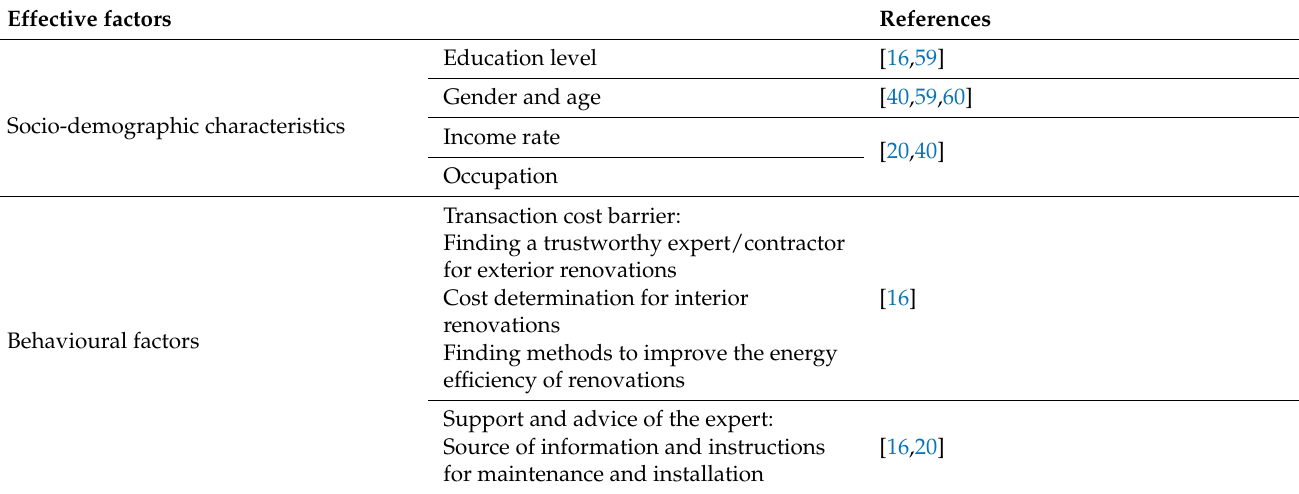
Table 3. Effective factors on energy efficiency renovation with respect to the occupants’